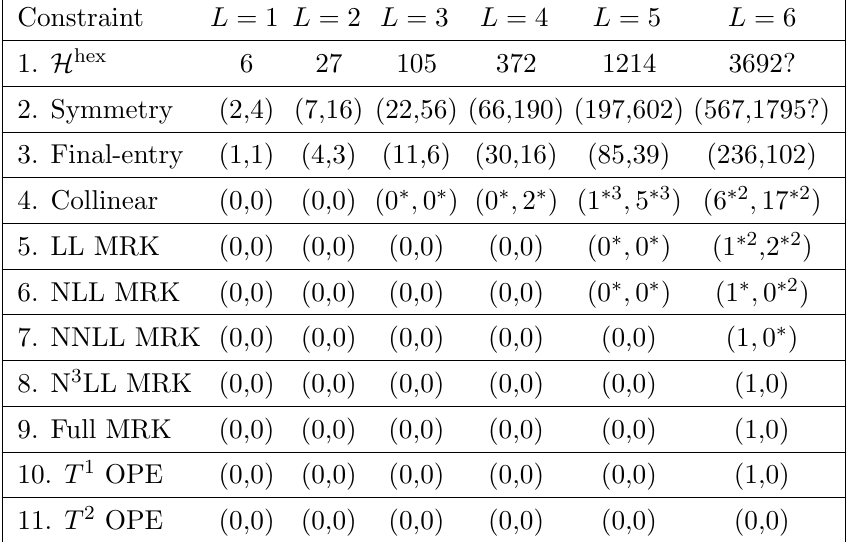
Table 1 . Remaining parameters in the ans(cid:127)atze for the (MHV, NMHV) amplitude after each con- straint is applied, at each loop order. The superscript \ (cid:3) " (\ (cid:3) n ") denotes an additional ambiguity ( n ambiguities) which arises only due to lack of knowledge of the cosmic normalization constant (cid:26) at the given stage. The \?" indicates an ambiguity about the number of weight 12 odd functions that are \dropouts"; they are allowed at symbol level but not function level. The seven-loop MHV amplitude was constrained in a somewhat di(cid:11)erent order. As the parameter counts are not directly comparable it is omitted from the